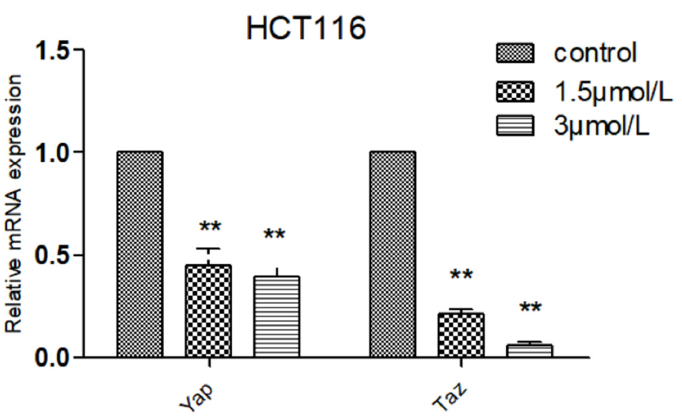
Figure 9. The effect of DTB on the expression of mitochondrial-related genes BCL-2, BAX, and TP53 in colon cancer cells HCT 116. n = 3; compared with the blank group, ** p < 0.01, each data point represents the mean ± standard error.